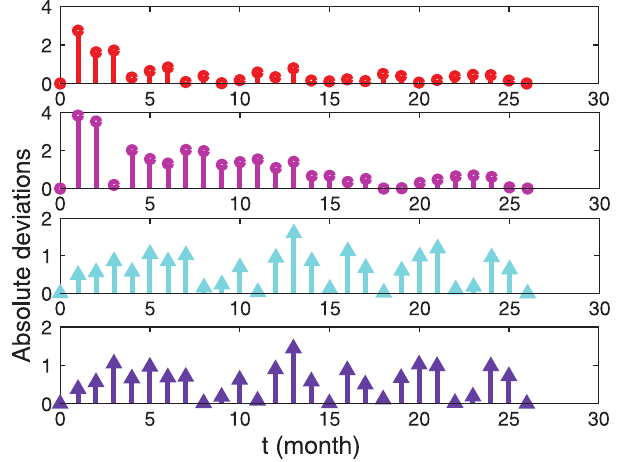
Figure 4. Deviations between experimental, analytical and numerical results for the TB-infection case. Absolute difference between experimental data and theoretical data reported in Fig. 3; the same legend holds.